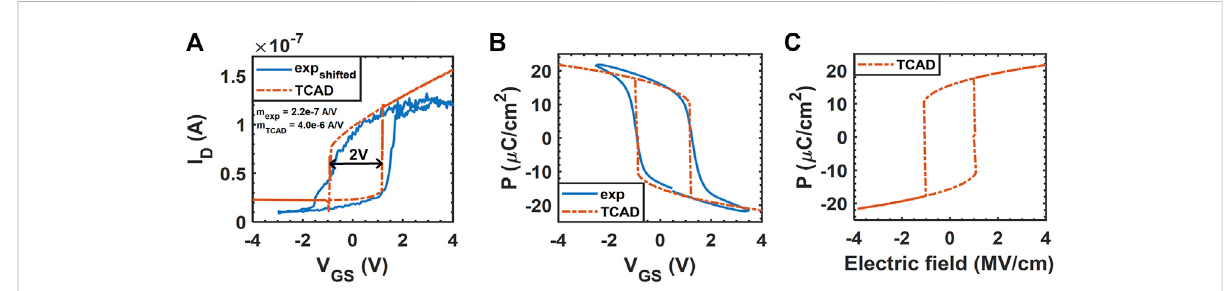
FIGURE 2 Experimental(solid blueline)andsimulation(dash-dotted redline)DCcharacteristicsfortheFeFETinFigure1withan8 nm-thick WO x channel